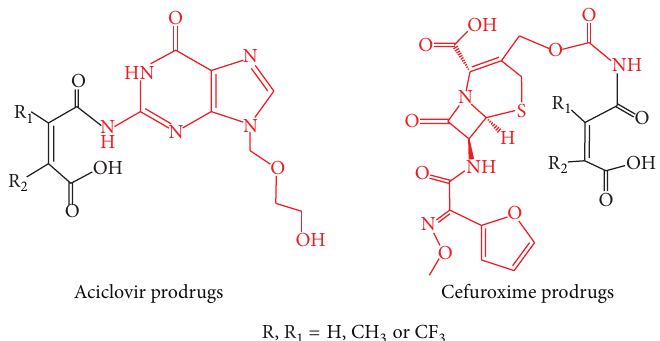
Figure 5: Chemical structures for aciclovir and cefuroxime